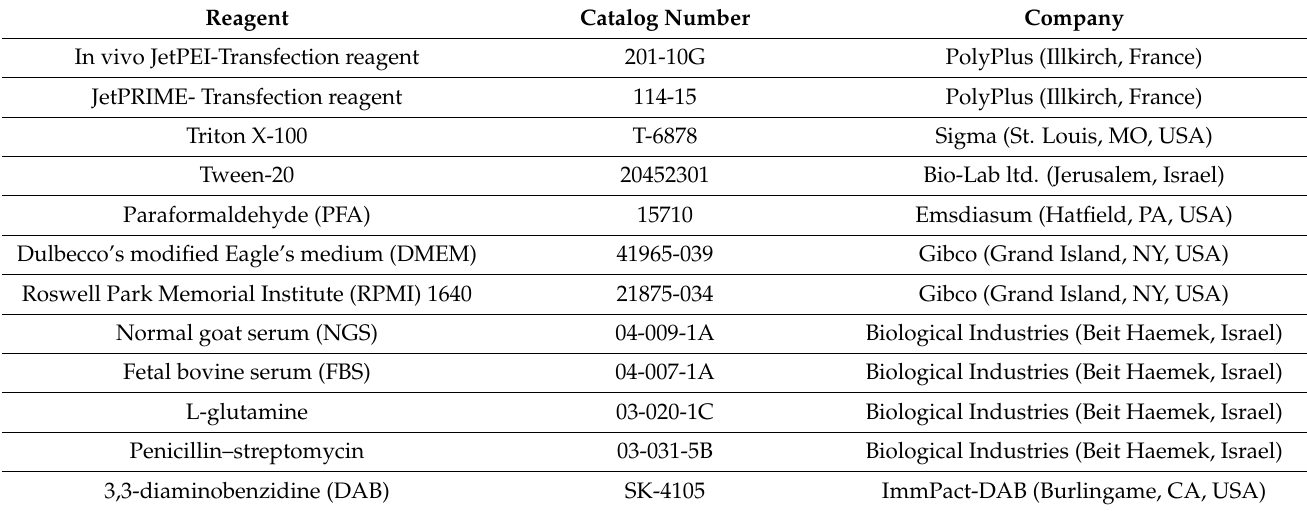
Table 1. List of chemicals and reagents used in this